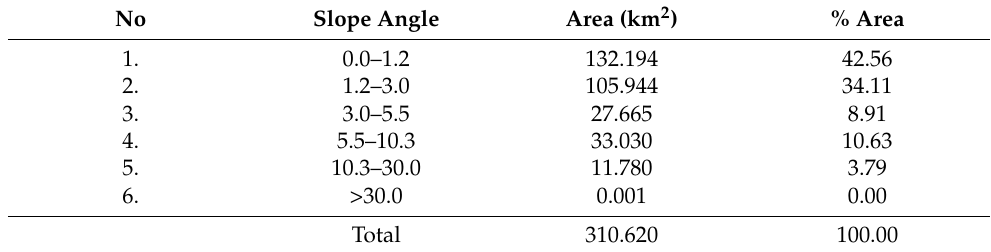
Table 4. Classification of the slope of the Krueng Teunom watershed and its coverage area.